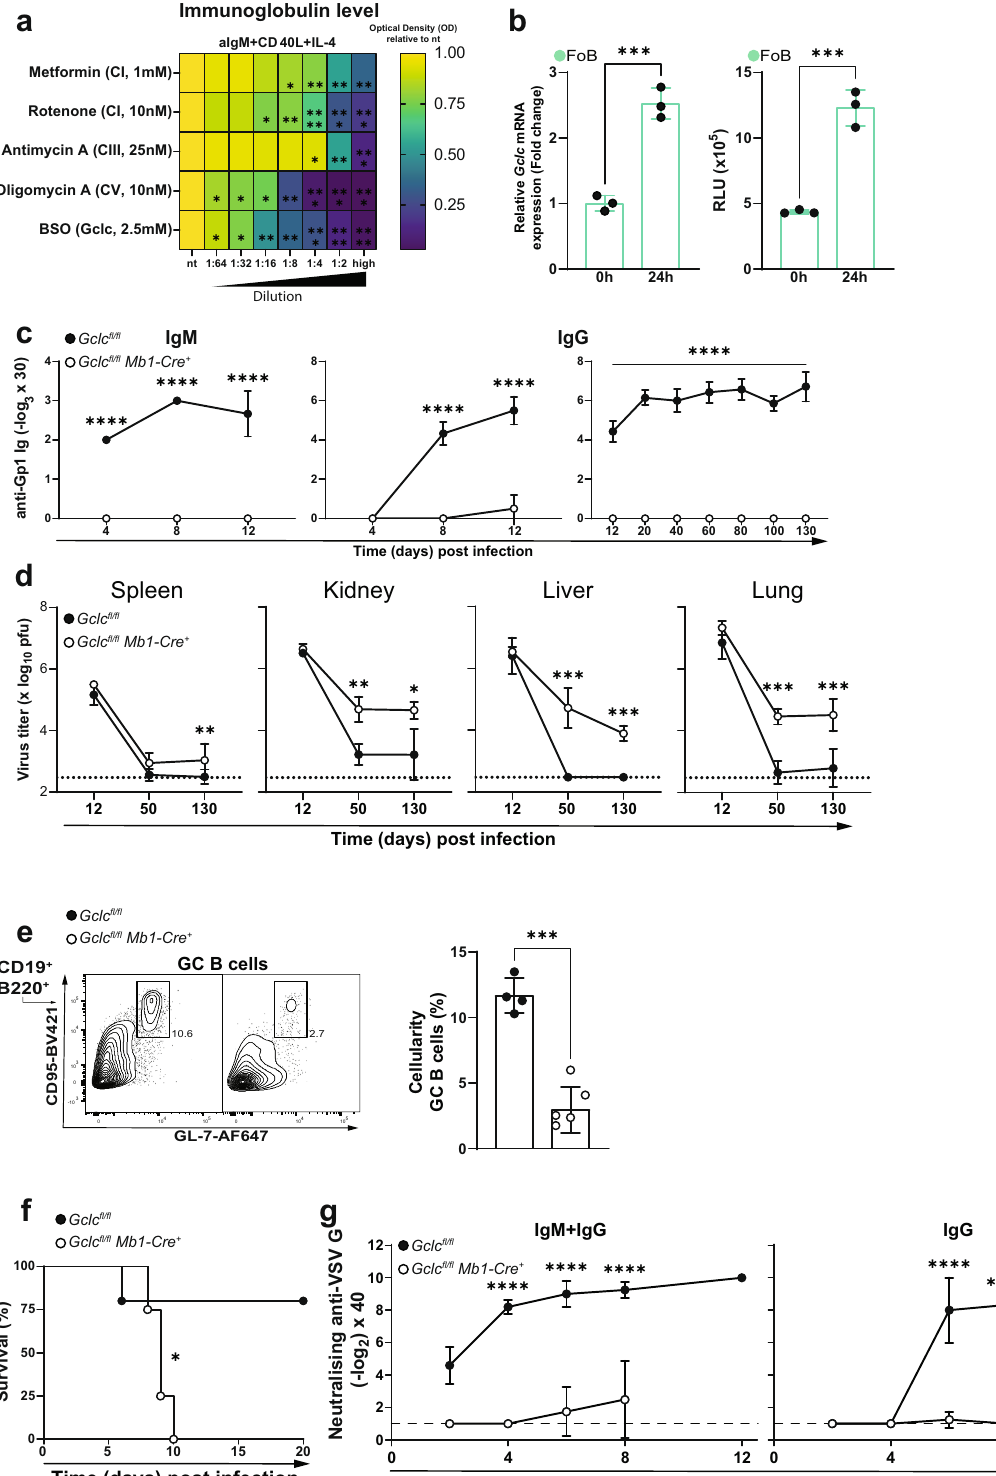
regulation of cellular labile copper pools 116 . These labile copper pools are important for the assembly of iron-sulfur (FeS) clusters, which are directly linked to mitochondrial function 117,118 . Moreover, GSH-independent roles of Gclc associated with its direct product — γ -glutamylcysteine ( γ -GluCys) — might in fl uence the downstream regulation of biosynthetic pathways of amino acids (and/or their transport) 119 in MZB and FoB.